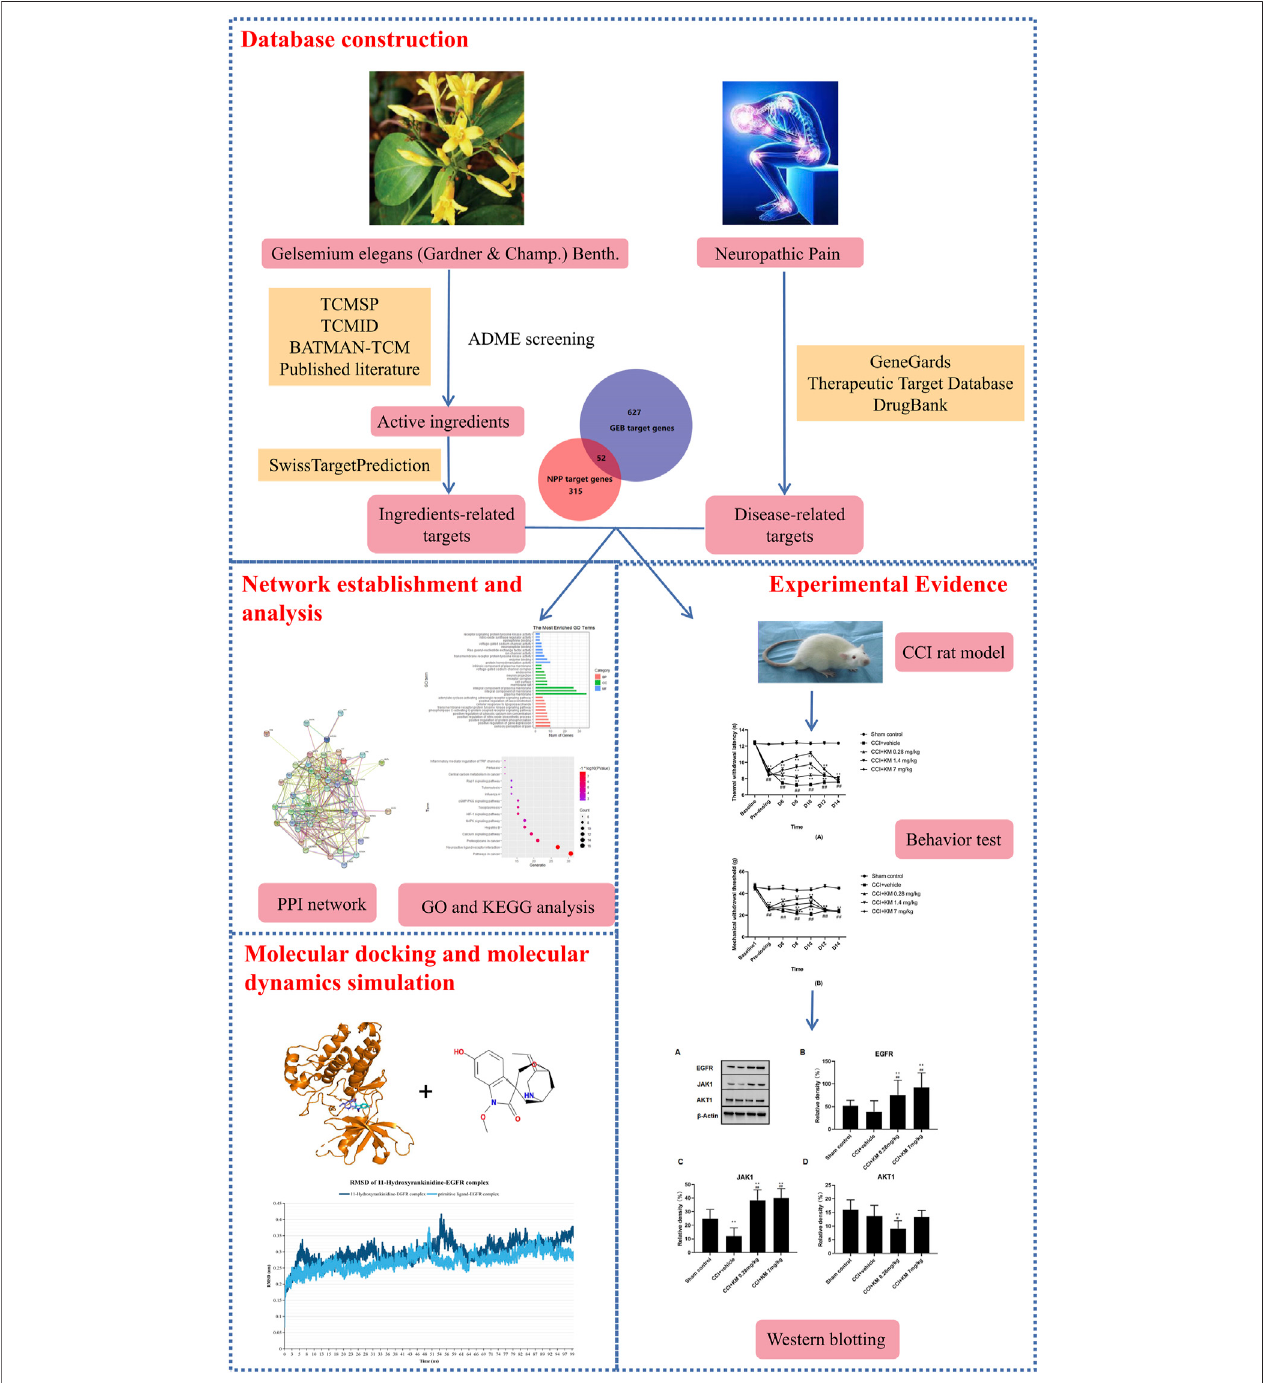
FIGURE 1 | The fl owchart of network pharmacology